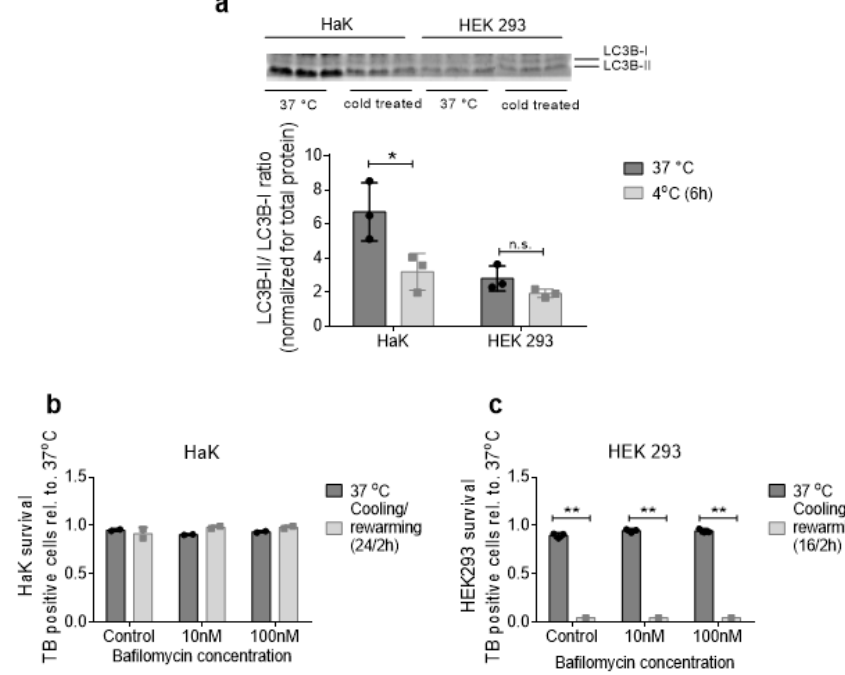
Figure 5. Autophagy activity in normothermic and hypothermic HaK and 293 cells. ( a ). Protein expression for LCB3-II and LCB3-I, expressed as LCB3-II/LC3B-I ratio. Normalized for total protein. Both in normothermic and hypothermic (4 °C, 6 h cooling) circumstances. ( b ) Survival after hypothermic in bafilomycin (autophagy inhibiter) treated HaK and ( c ) HEK 293 cells. All data presented as mean ± SD. * = p < 0.05, ** = p < 0.01; ANOVA post hoc Bonferroni. n.s. = non-significant.